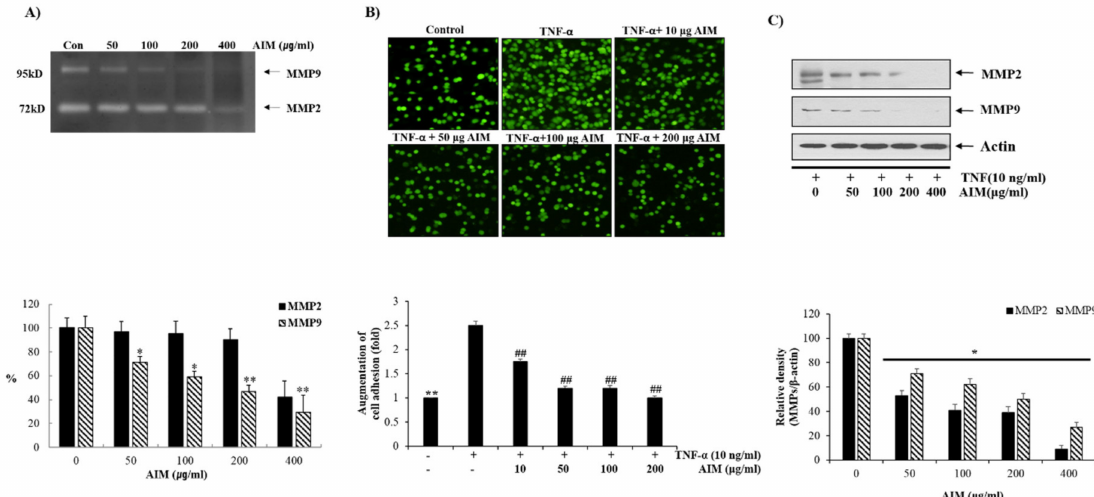
Figure 2. Inhibitory e ff ects of AIM on cancer cell adhesion of MCF-7 Cells. ( A ) The cells were grown in 6-well plates with the seeding density of 5 × 10 4 cells / well. MMP-2 and MMP-9 levels in gelatin zymography were assessed by densitometry. (Upper) The cells were treated with and without AIM for 24 h and the conditioned medium was taken to perform gelatin zymography. (Lower) MMP-2 and MMP-9 are expressed as a percentage of the activities against untreated cells. ( B ) The cells were seeded at the density of 5 × 10 4 cells / mL. The cells were treated with indicated concentrations of AIM (0, 50, 100, and 200 µ g / mL) for 24 h and the AIM e ff ect on cancer cell invasion was assessed. For the group treated with AIM and TNF- α , cells were pre-treated with AIM (0, 10, 50, 100, and 200 µ g / mL) for 1 h and then treated with TNF- α (10 ng / mL). ** p < 0.01 vs. the control group, ## p < 0.01 vs. the TNF-treated group. ( C ) Cells (5 × 10 4 cells), either left untreated or pre-treated with AIM for 1 h, were exposed to TNF- α (10 ng / mL) for 24 h. (Upper) 30 µ g of whole cell protein lysate were used for western blot analysis using antibodies of MMP-2 and MMP9. (Lower) Densitometry analysis of the data in western blot analysis by ImageJ software. The values were normalized against β -actin. ** p < 0.01 vs. the control